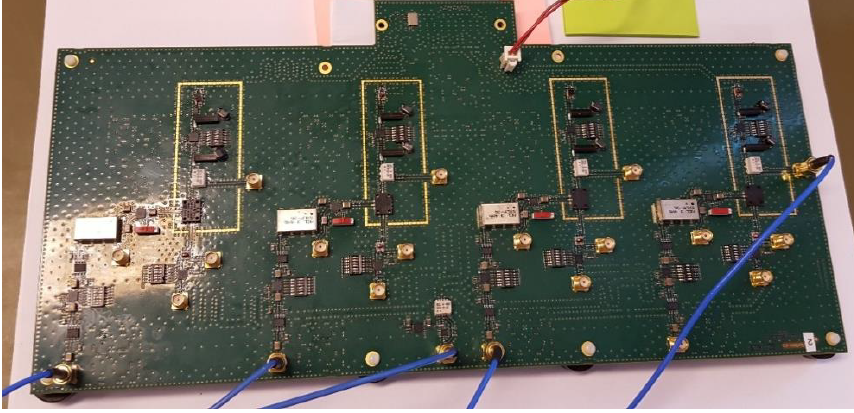
Figure 4. Our analog acquisition board.